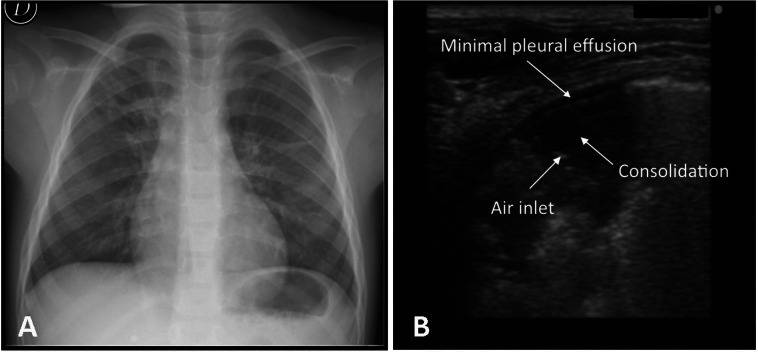
One case of negative chest X-ray and positive lung ultrasound.Negative chest X-ray result for a 4 year old female (A) and evidence of pneumonia in the posterior basal retrocardiac region of left lung by lung ultrasound (B).